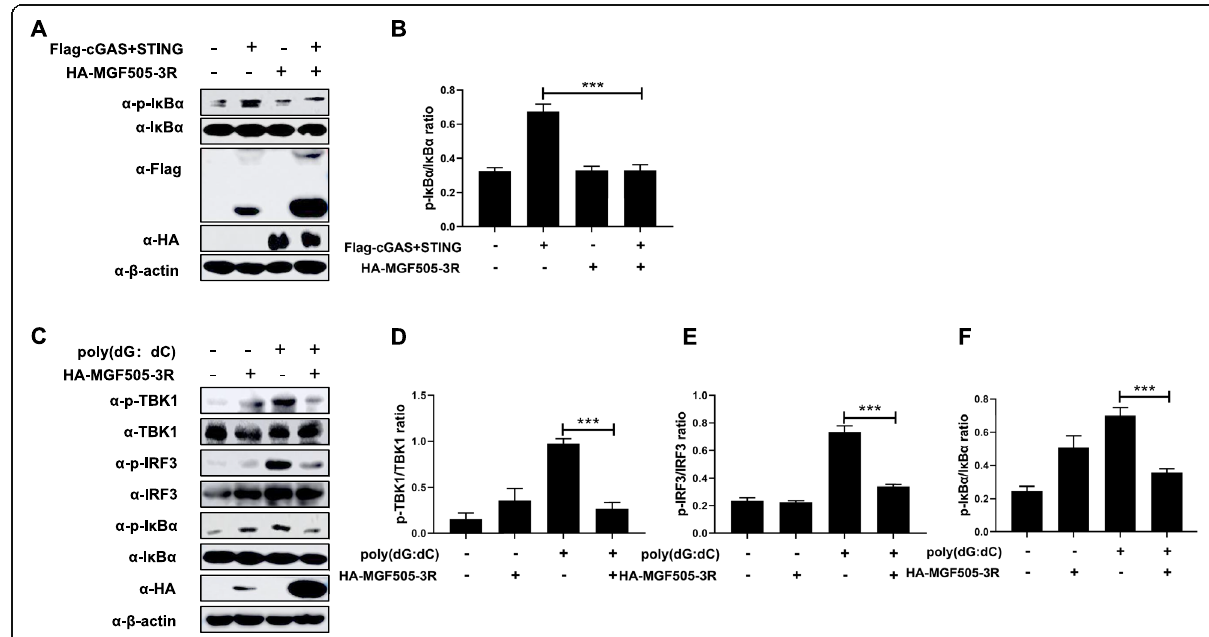
Fig. 2 MGF505-3R suppressed the phosphorylation levels of signaling molecules. A-B HEK293T cells were cotransfected with Flag-cGAS (500 ng), Flag-STING (500 ng), and HA-MGF505-3R plasmids (1 μ g). Twenty-four hours after transfection, the cells were collected at the indicated times. C-F Twenty hours after transfection with HA-MGF505-3R, HEK293T cells were left untreated or treated with poly (dG:dC) (1.5 μ g) for 12 h before being collected. “ + ” represents transfected, “ - ” represents nontransfected. For all cell lysates, the target proteins were detected by western blotting. Quantitative analysis of protein blots was performed using ImageJ software. All experiments were repeated independently at least thrice. The data from independent experiments are shown as the mean ± SD; n =3. * P <0.05, ** P <0.01, *** P